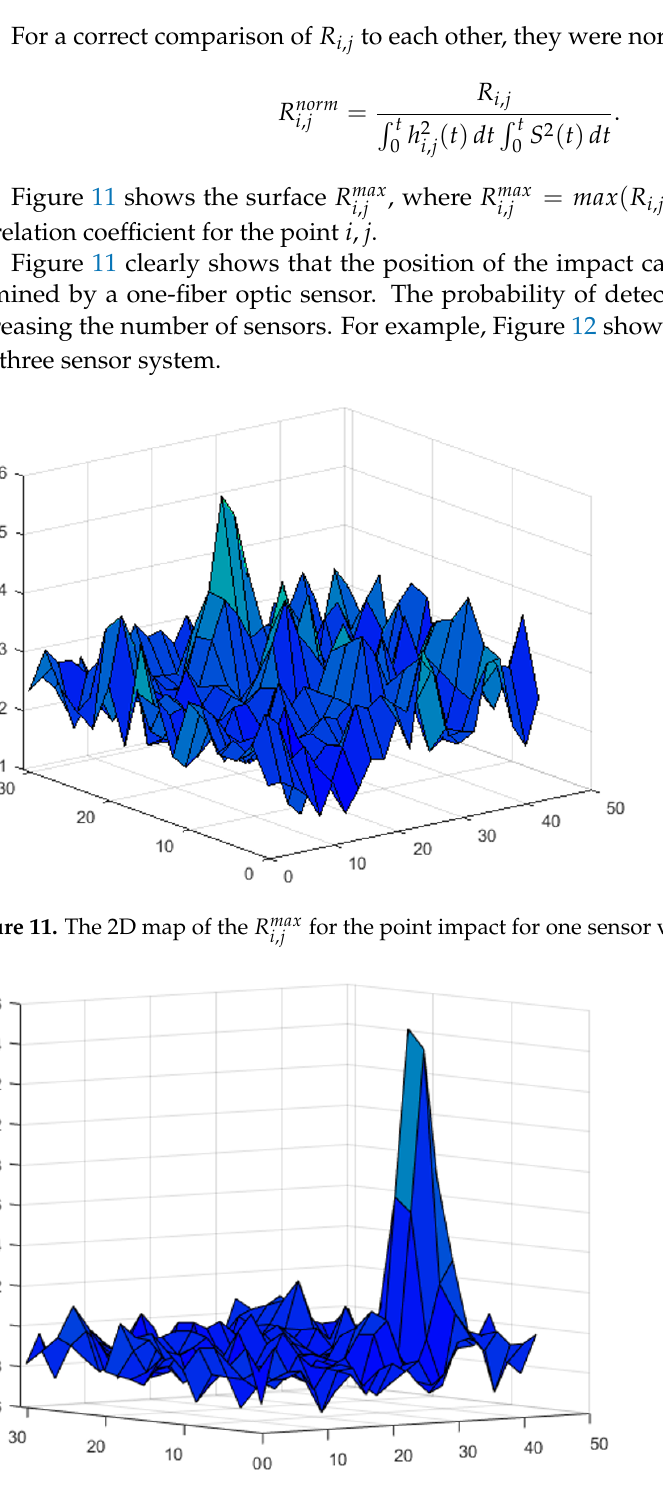
Figure 12. The 2D map of the R max